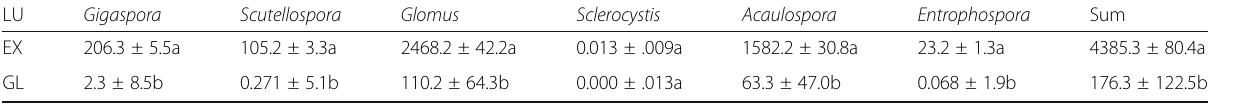
Table 2 Spore density and spore genera in exclosures and grazing land (100 g − 1 dry soil)